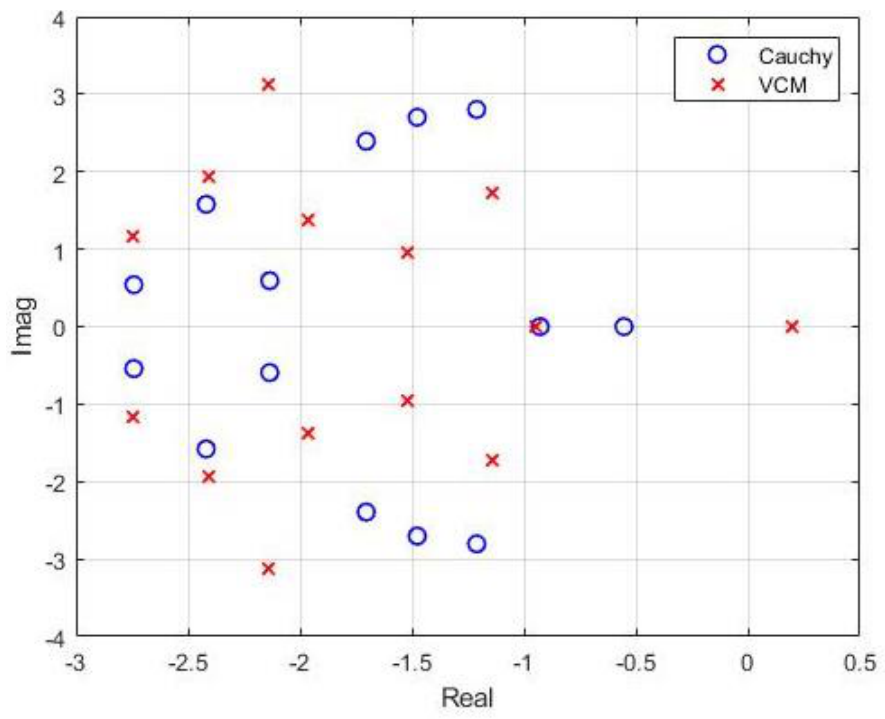
Figure 7. CNRs calculated with Cauchy and VCM that were used to reconstruct the backscattered signals of the metal cylinder in free space.